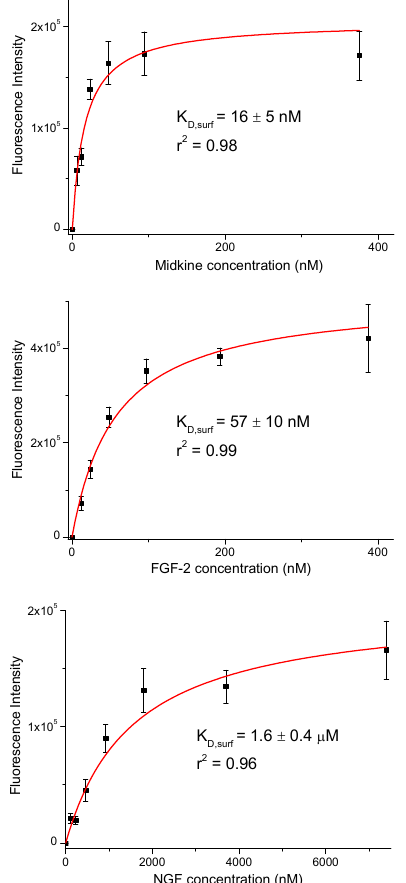
Figure 2. Binding curves for the interactions between immobilized hexasaccharide 17 and midkine, FGF-2 and NGF. The displayed fluorescence intensity values are the averages of at least three replicate wells and the error bars represent the standard deviations.